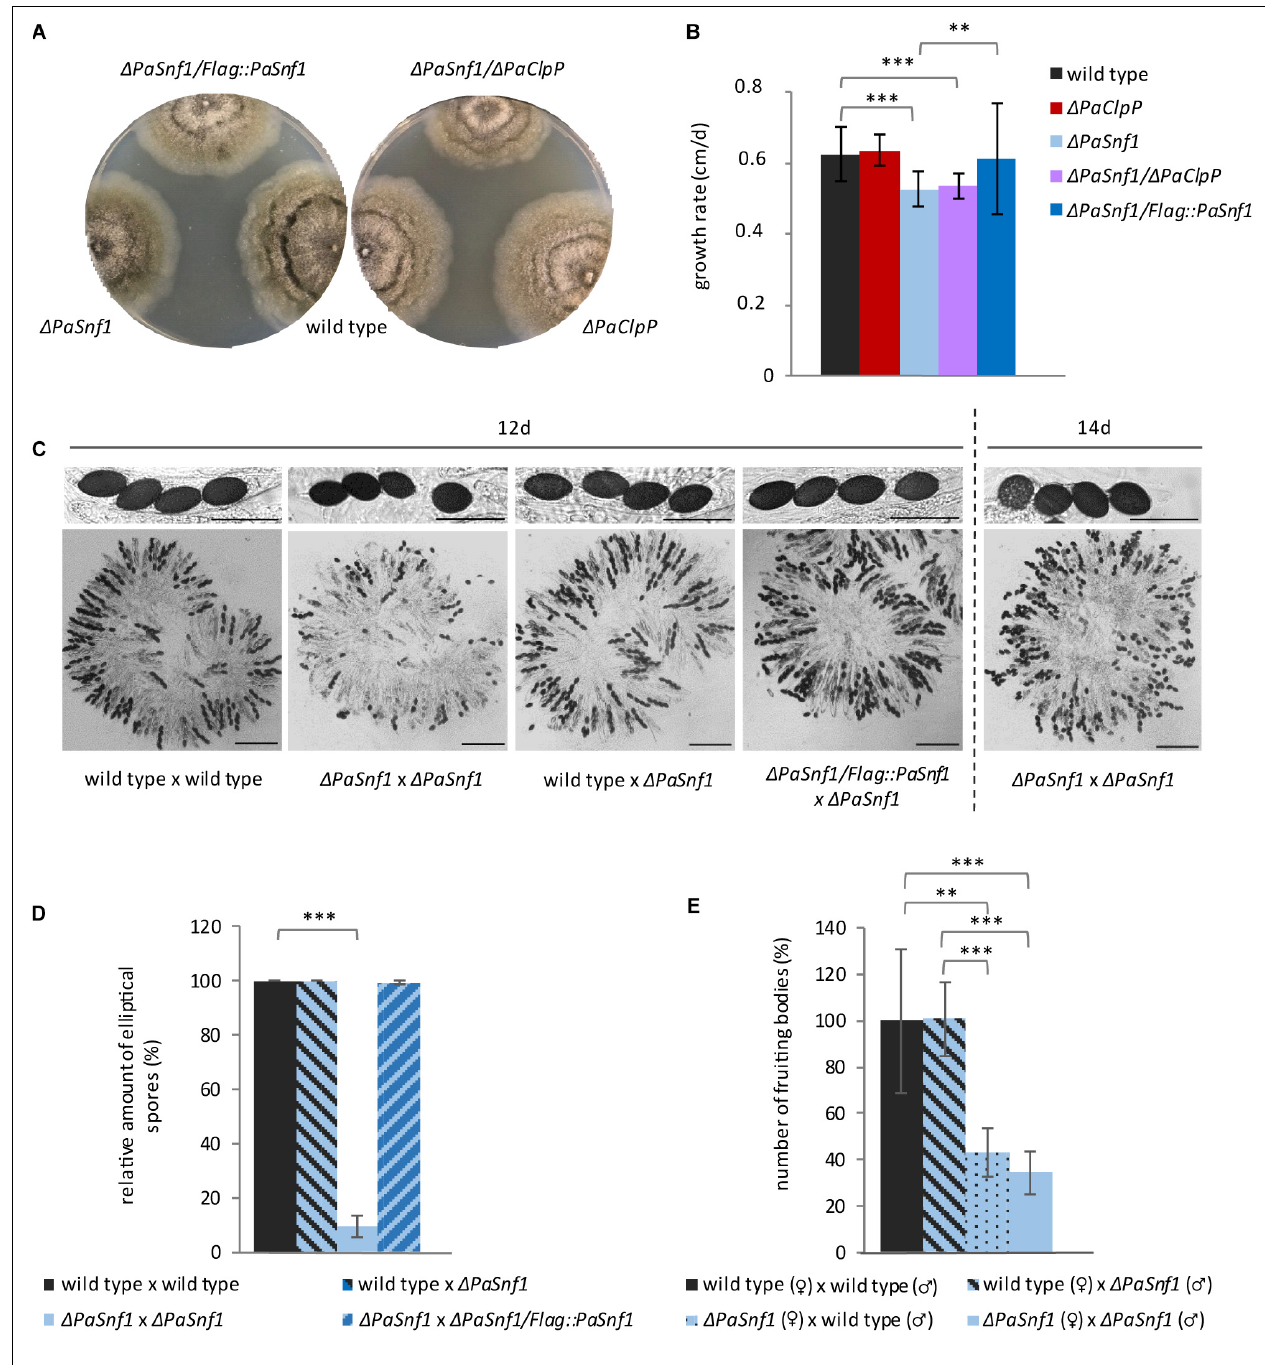
FIGURE 2 | Ablation of PaSNF1 affects growth rate and fertility. (A) Phenotypes of (cid:49) PaSnf1 , (cid:49) PaClpP , and (cid:49) PaSnf1 / (cid:49) PaClpP ; the complementation strain (cid:49) PaSnf1 / Flag::PaSnf1 ; and the wild type at the age of 9 days on M2 medium, cultivated at 27 ◦ C and in constant light. (B) Growth rate of (cid:49) PaSnf1 ( n = 28), (cid:49) PaClpP ( n = 22), (cid:49) PaSnf1 / (cid:49) PaClpP ( n = 25), (cid:49) PaSnf1 / Flag::PaSnf1 ( n = 21), and wild type ( n = 32) on M2 medium at 27 ◦ C and in constant light. (C) Content of fruiting bodies from cultures after a 12-day incubation of pairs of opposite mating types (confrontational crosses) of two wild-type strains, of two (cid:49) PaSnf1 strains, of wild type × (cid:49) PaSnf1 , or of (cid:49) PaSnf1 / Flag::PaSnf1 × (cid:49) PaSnf1 , respectively. ( C , right) Content of a fruiting body of the cross of two (cid:49) PaSnf1 after two additional days of incubation (14 day). Scale bar of fruiting body content corresponds to 250 µ m and the scale bar of ascus pictures corresponds to 100 µ m. (D) Quantification of spore morphology. Only mature black spores (10 fruiting bodies of each cross) were evaluated and the relative amount of elliptical spores is indicated. Evaluated ascospores of specific crosses: wild type × wild type n = 1691 spores, (cid:49) PaSnf1 × (cid:49) PaSnf1: n = 760; wild type × (cid:49) PaSnf1 : n = 1595; (cid:49) PaSnf1 / Flag::PaSnf1 × (cid:49) PaSnf1 : n = 1423. (E) Relative amount of fruiting bodies resulting from the spermatization of the wild type ( n = 6) and (cid:49) PaSnf1 ( n = 6) with different male or female partners. (B,D,E) The values presented are mean values ± SD ( ∗∗∗ p < 0.001; ∗∗ p < 0.01, two-tailed Student’s t -test).